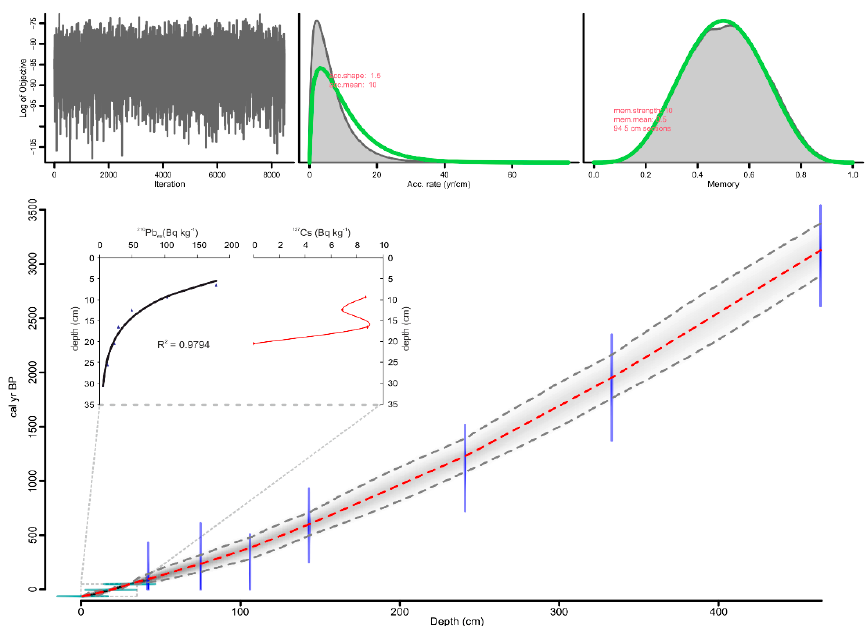
Figure 2. Age–depth model of the composite core ND2. Blue bars indicate the 14 C age distribution; the greyscale of the line graph reflects the likelihood; the dotted red line follows the mean ages. Radionuclides analysis of 210 Pb and 137 Cs and the relative activity–depth profile is reported for the upper 30 cm [29].